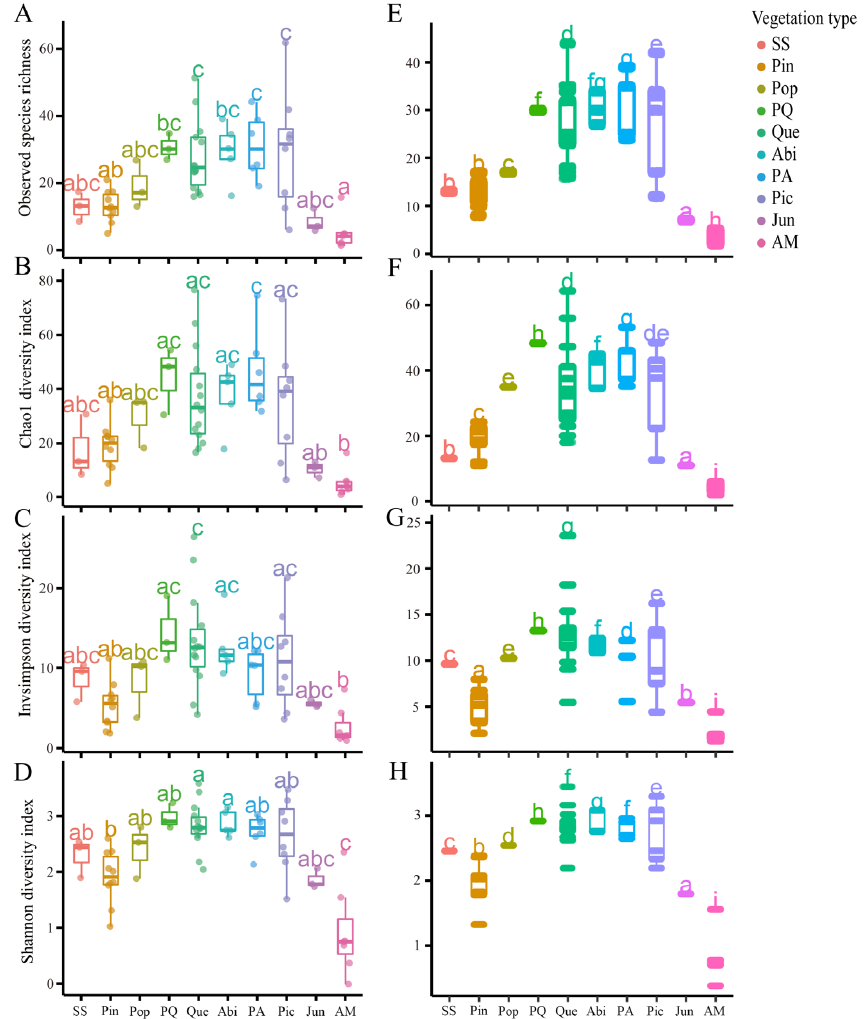
Figure 6. Alpha diversity analysis based on different vegetation types. Observed species richness ( A ), Chao1 diversity index ( B ), invsimpson diversity index ( C ), Shannon diversity index( D ); post-correction observed species richness ( E ); post-correction Chao1 diversity index ( F ),